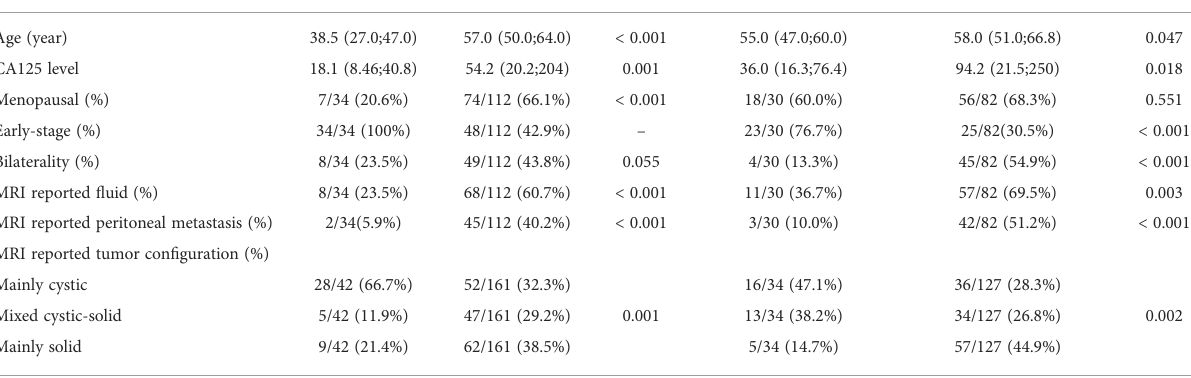
TABLE 1 Patients